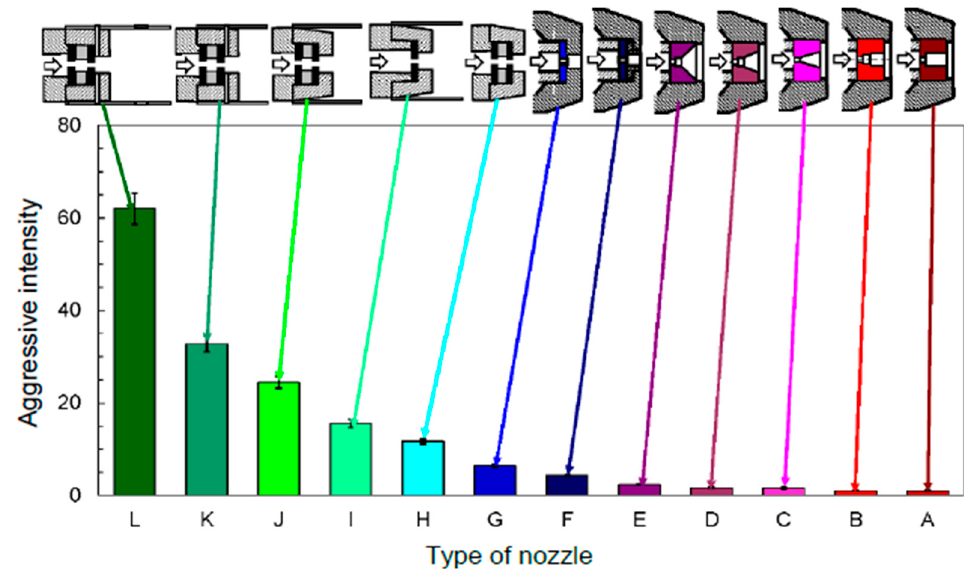
Figure 20. Effect of nozzle outlet geometry on aggressive intensity of cavitating jet. Figure 20. E ff ect of nozzle outlet geometry on aggressive intensity of cavitating